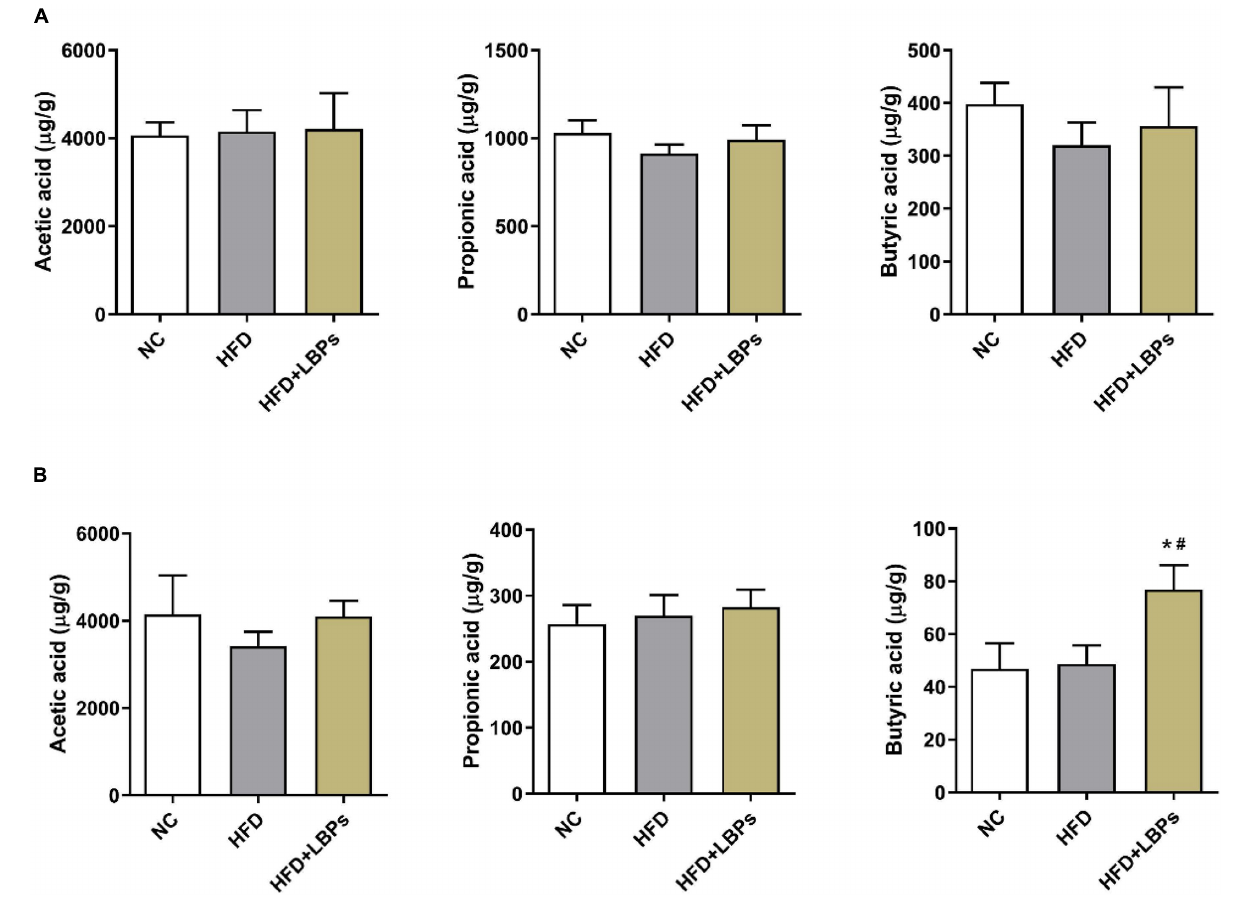
FIGURE 7 | Effects of Lycium barbarum polysaccharides (LBPs) on SCFAs production in (A) colonic, and (B) fecal contents. * P < 0.05 vs. NC group and # P < 0.05 vs. HFD group.